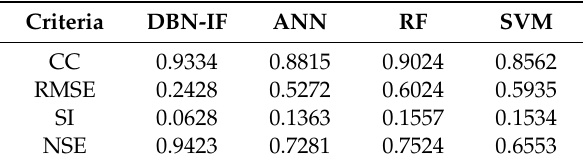
Table 10. The CC, RMSE, SI, NSE of WVHT predictions with lead time = 6 h.